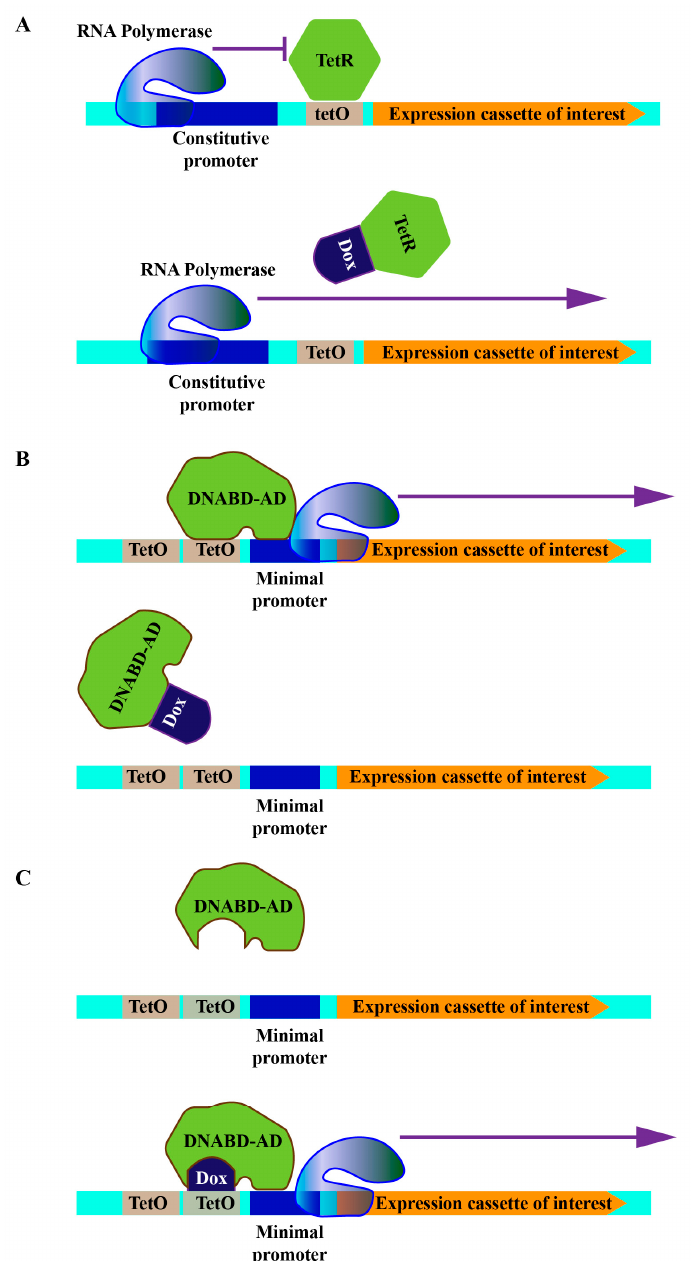
Figure 1. Schematic representations of tetracycline-controled operator systems. ( A ) Repression based configuration. ( B ) Tet-o ff configuration. ( C ) Tet-on configuration. DNABD: DNA binding domain, AD: activating domain, TetO: tetracycline operator, Dox: doxycycline, TetR: tet